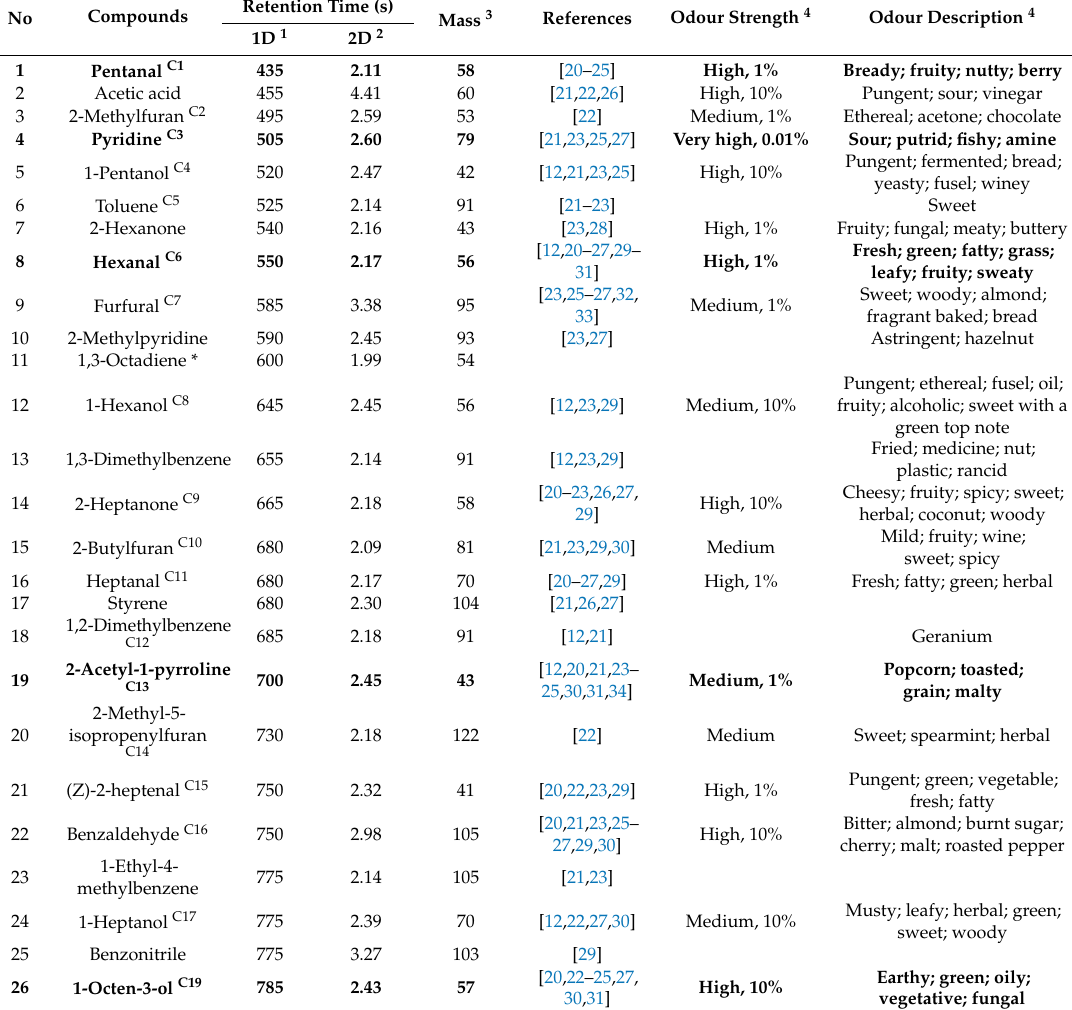
Table 1. GC × GC-TOFMS analysis for volatiles in six Indonesian rice